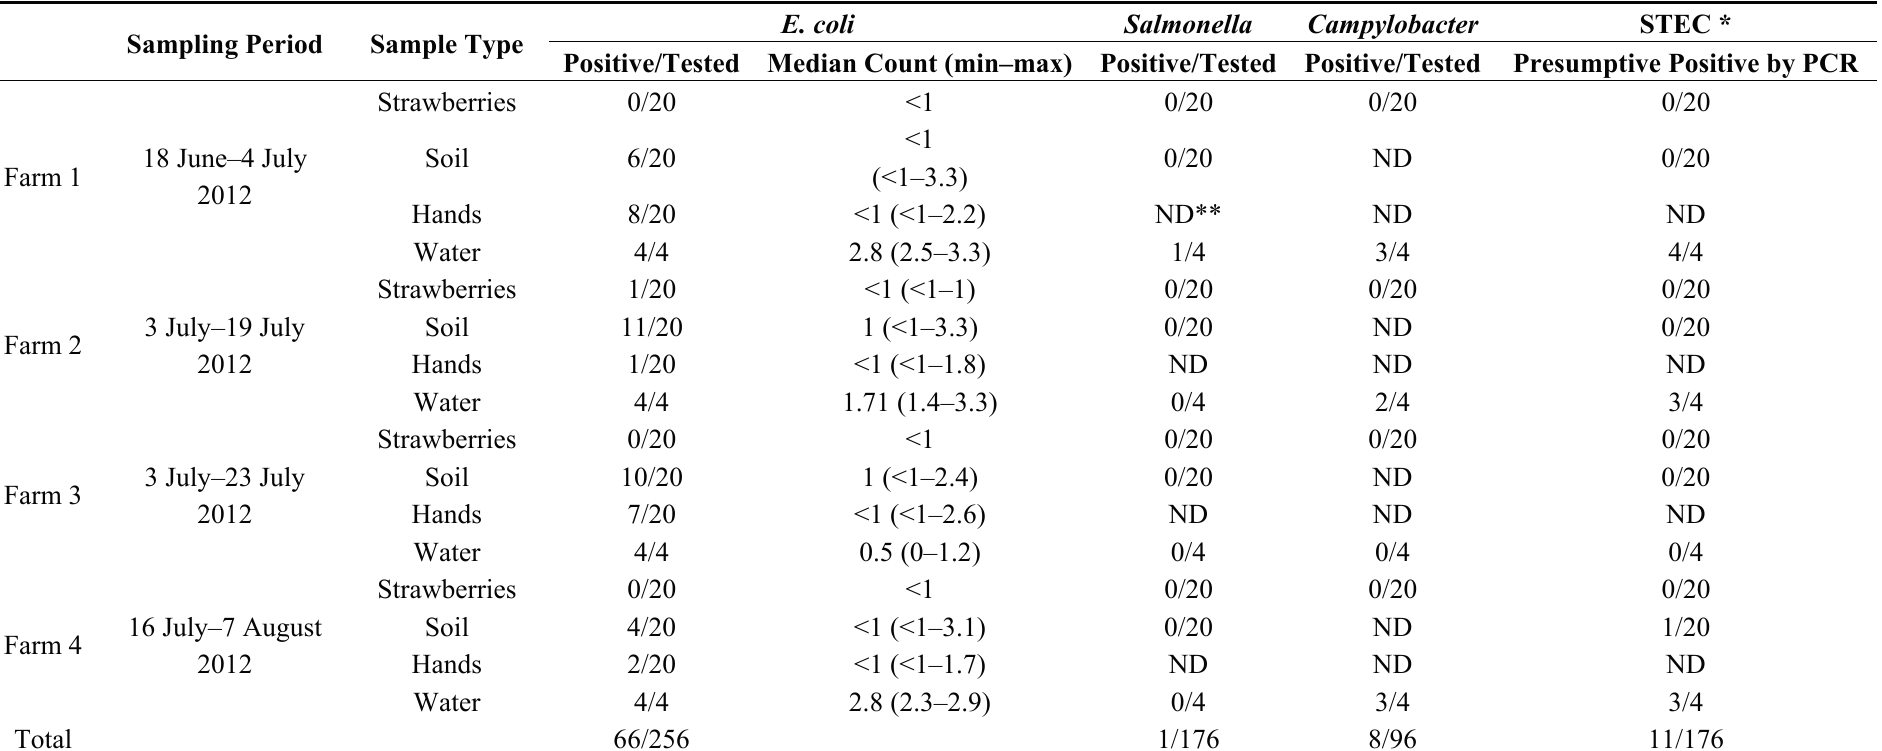
Table 2. Frequency of occurrence (positive/tested) and counts (log 10 cfu/g, log 10 cfu/hand or log 10 MPN/100 mL water) of selected bacteria in strawberries, soil, irrigation water and picking hand swabs obtained from four Norwegian strawberry